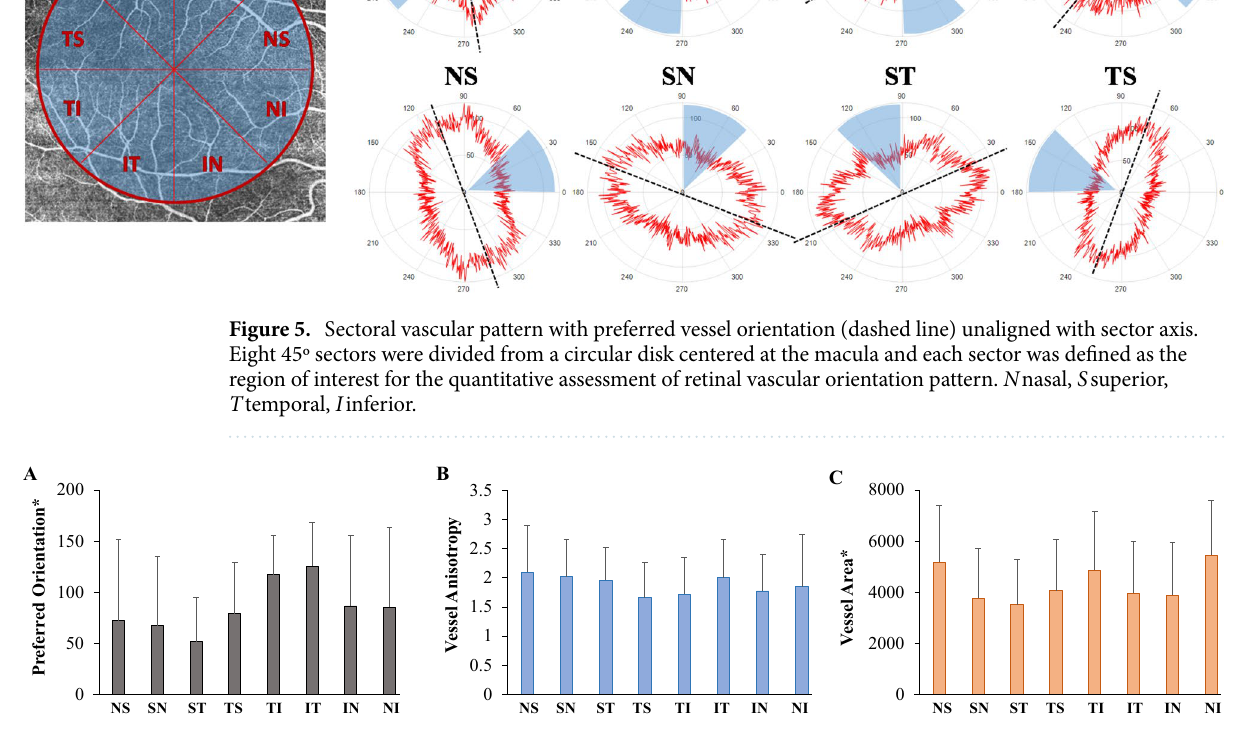
(TI: 4879 ± 2297 pixel 2 for healthy vs 2277 ± 1464 pixel 2 for DR, p = 0.004; IT: 3967 ± 2025 pixel 2 for healthy vs 2420 ± 1592 pixel 2 for DR, p = 0.046).